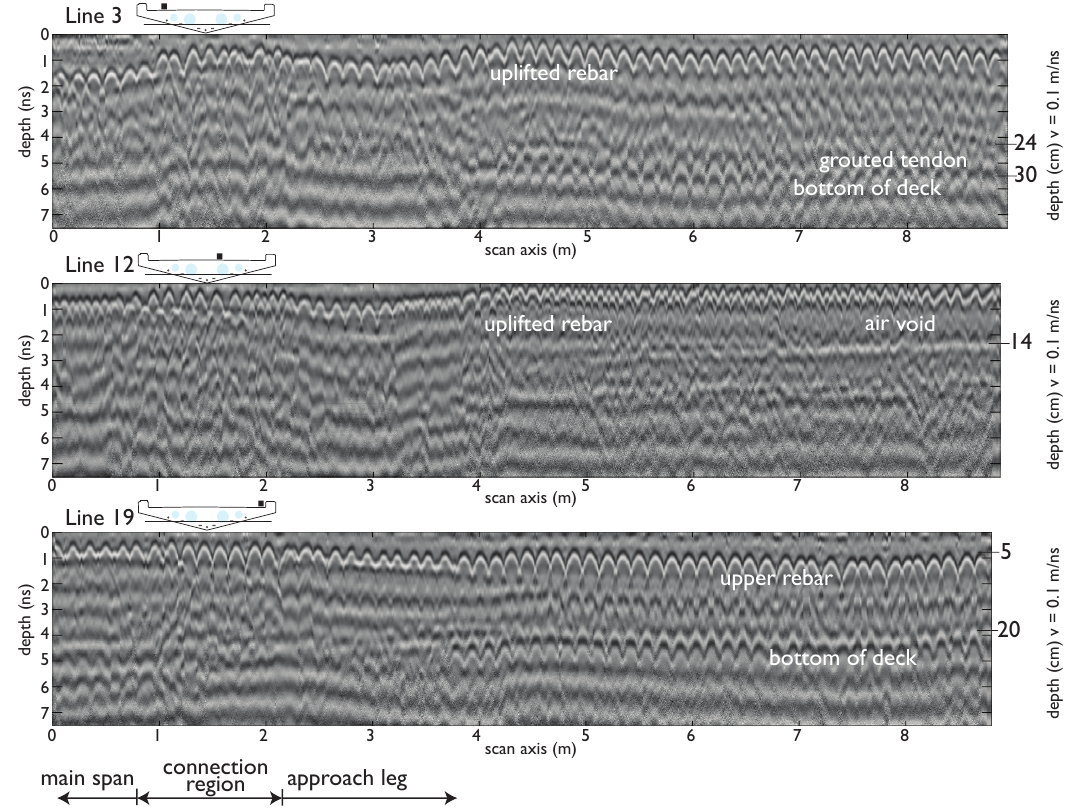
Figure 5. Processed unmigrated transects 3, 12, and 19 (SE leg) showing the internal features of the deck, with depths confirmed in construction documents using a nominal velocity of 0.1 m/ns. Note the lower rebar cage at the bottom of the deck and uplift of the upper rebar cage from the air